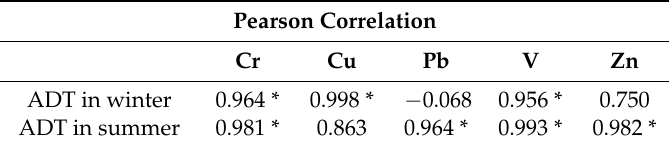
Table 3. Correlation analysis between the concentration of heavy metals and traffic volume. Pearson Correlation Cr